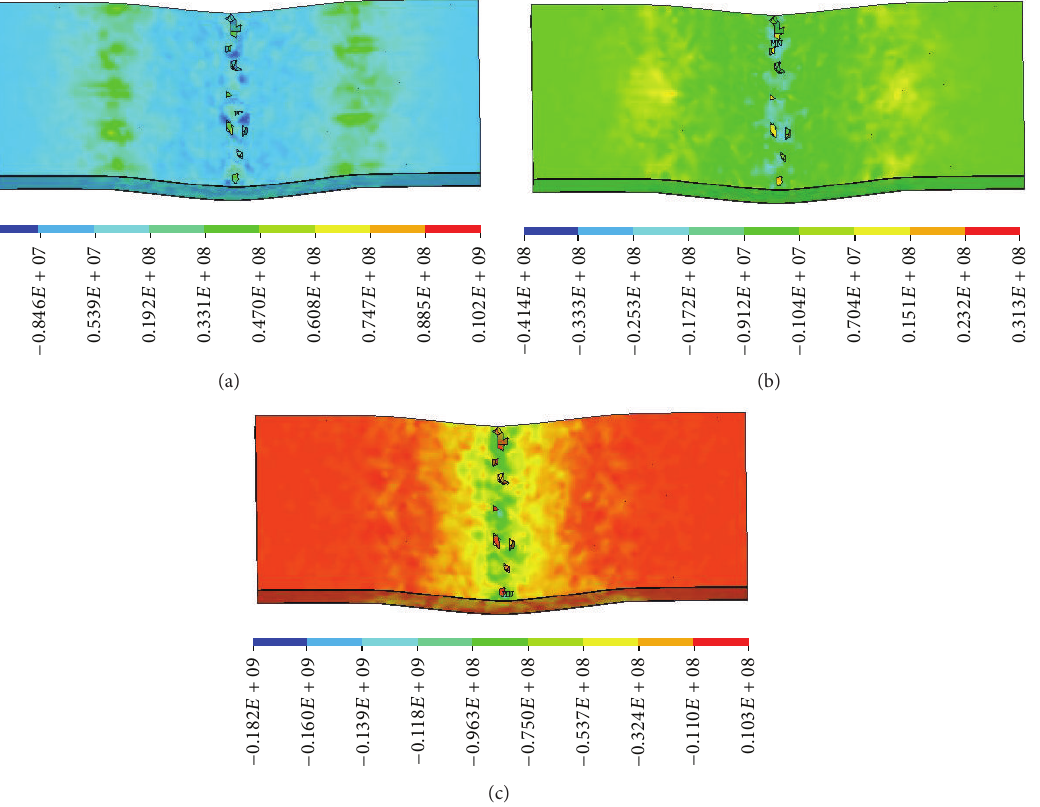
Figure 5: Full sandwich structure stress distribution: (a) 1st principal stress; (b) 2nd principal stress; (c) 3rd principal